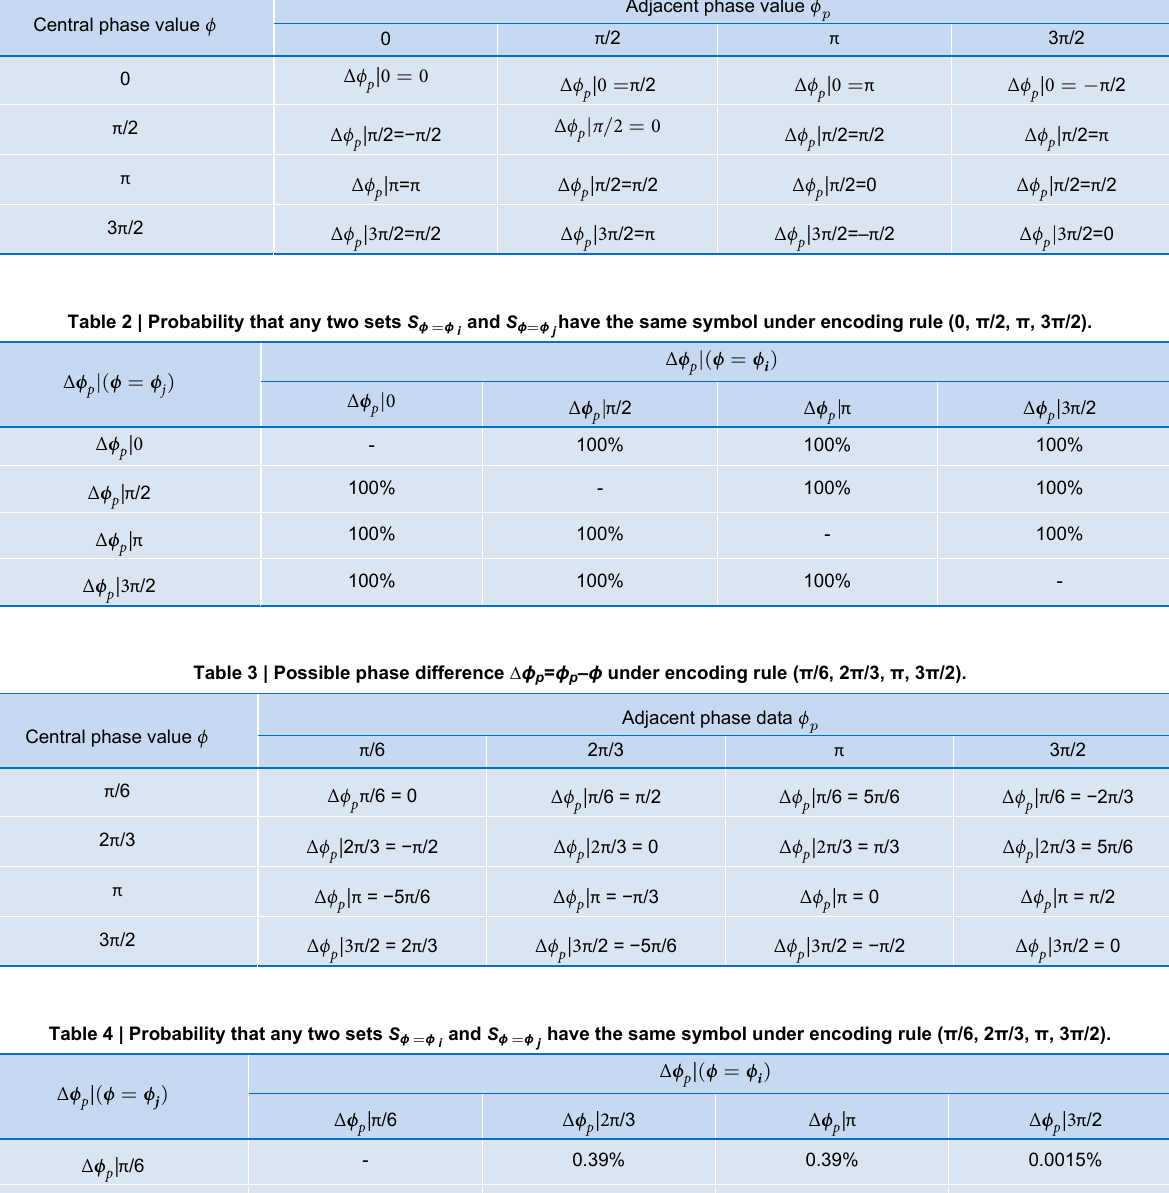
Table 1 | Possible phase difference ∆ ϕ p = ϕ p – ϕ under encoding rule (0, π/2, π, 3π/2). ϕ Central phase value